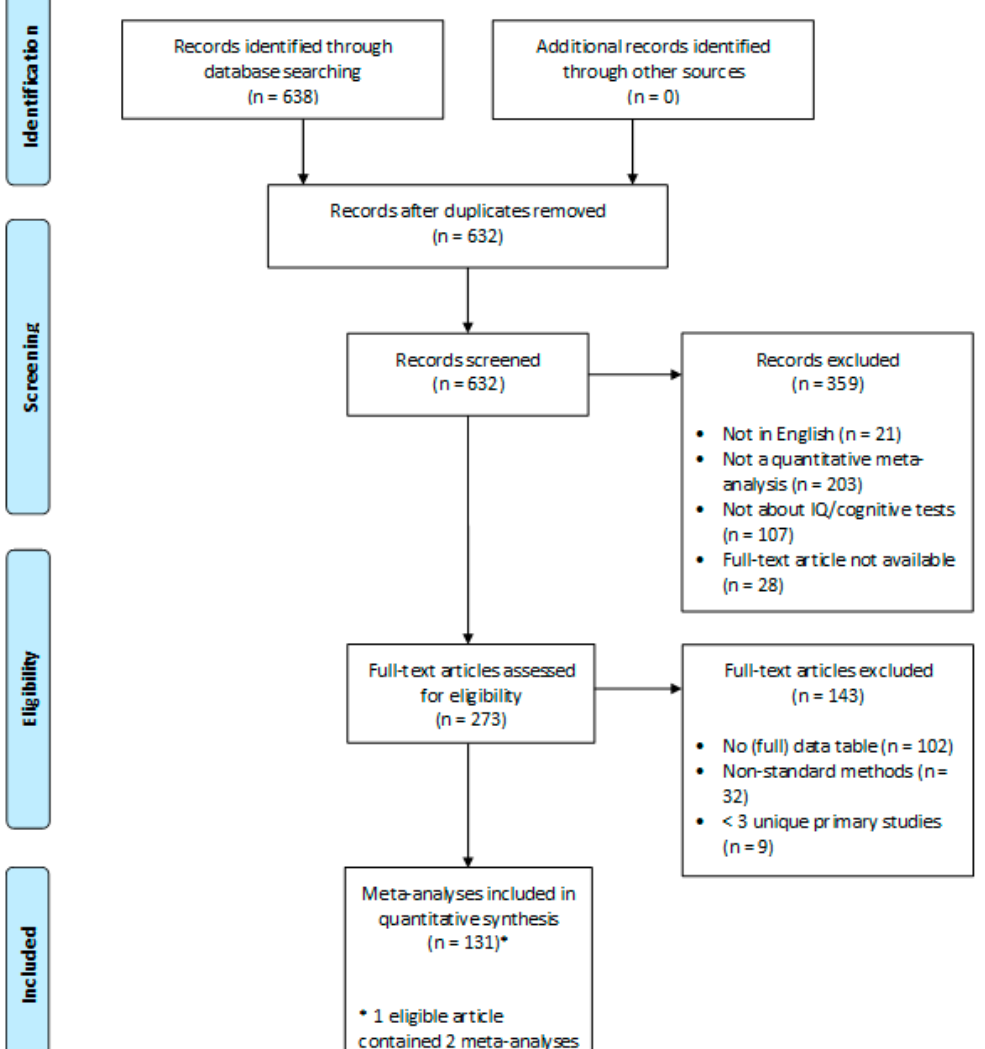
Figure 1. PRISMA Flow Diagram of the number of records identified, included and excluded, and the reasons for exclusions (Moher et al. 2009).